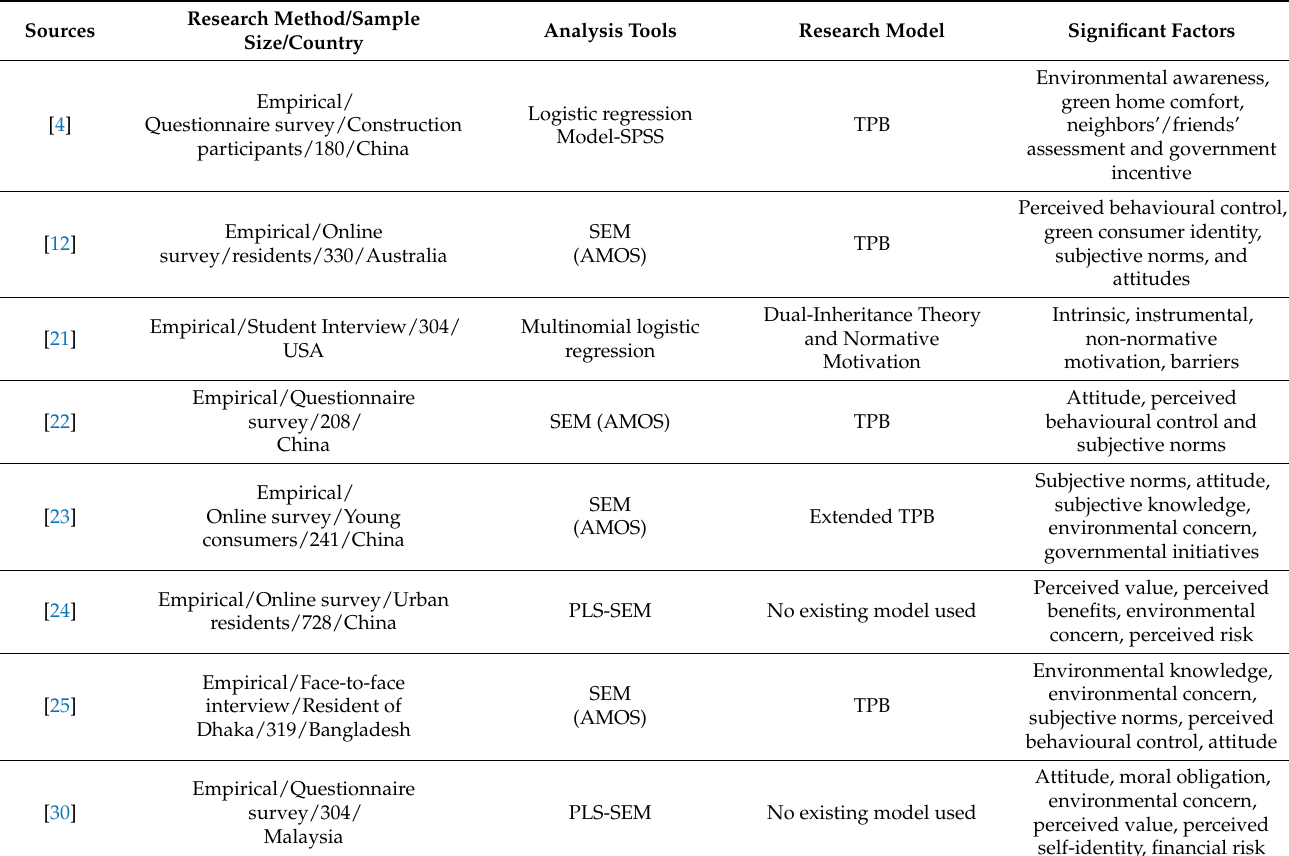
Table 1. Empirical research on the intention of buying green